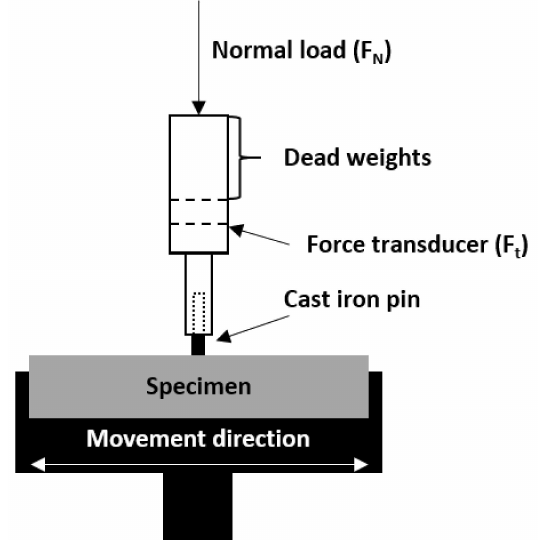
Figure 2. Schematic diagram of pin-on-block TM-01M tribometer used in